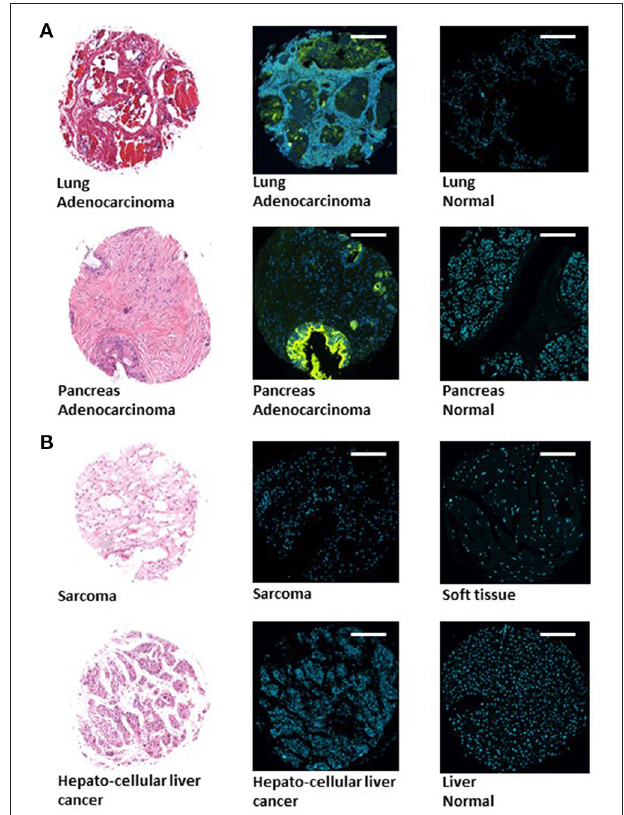
FIGURE 1 | Images of representative tumors displaying high and low Gal-GalNAc levels. Tissue microarray (TMA) (Boimax inc.: MC5003b, MC2082a, BN1002b) were used to quantify Gal-GalNAc in tumor and matching normal control sections. Lung (top) and pancreas (bottom) adenocarcinomas displaying high Gal-GalNAc levels are presented in (A) . Sarcoma (top) and hepatocellular liver cancer (bottom) non-adenocarcinoma tumors displaying low Gal-GalNAc levels are shown in (B) . Left panels present H&E staining. Middle and right panels present FITC-labeled Gal-GalNAc-specific PNA (green) and Hoechst dye (blue) of tumor (middle panel) and normal (right panel). Bars shown are 250 µ m scale.